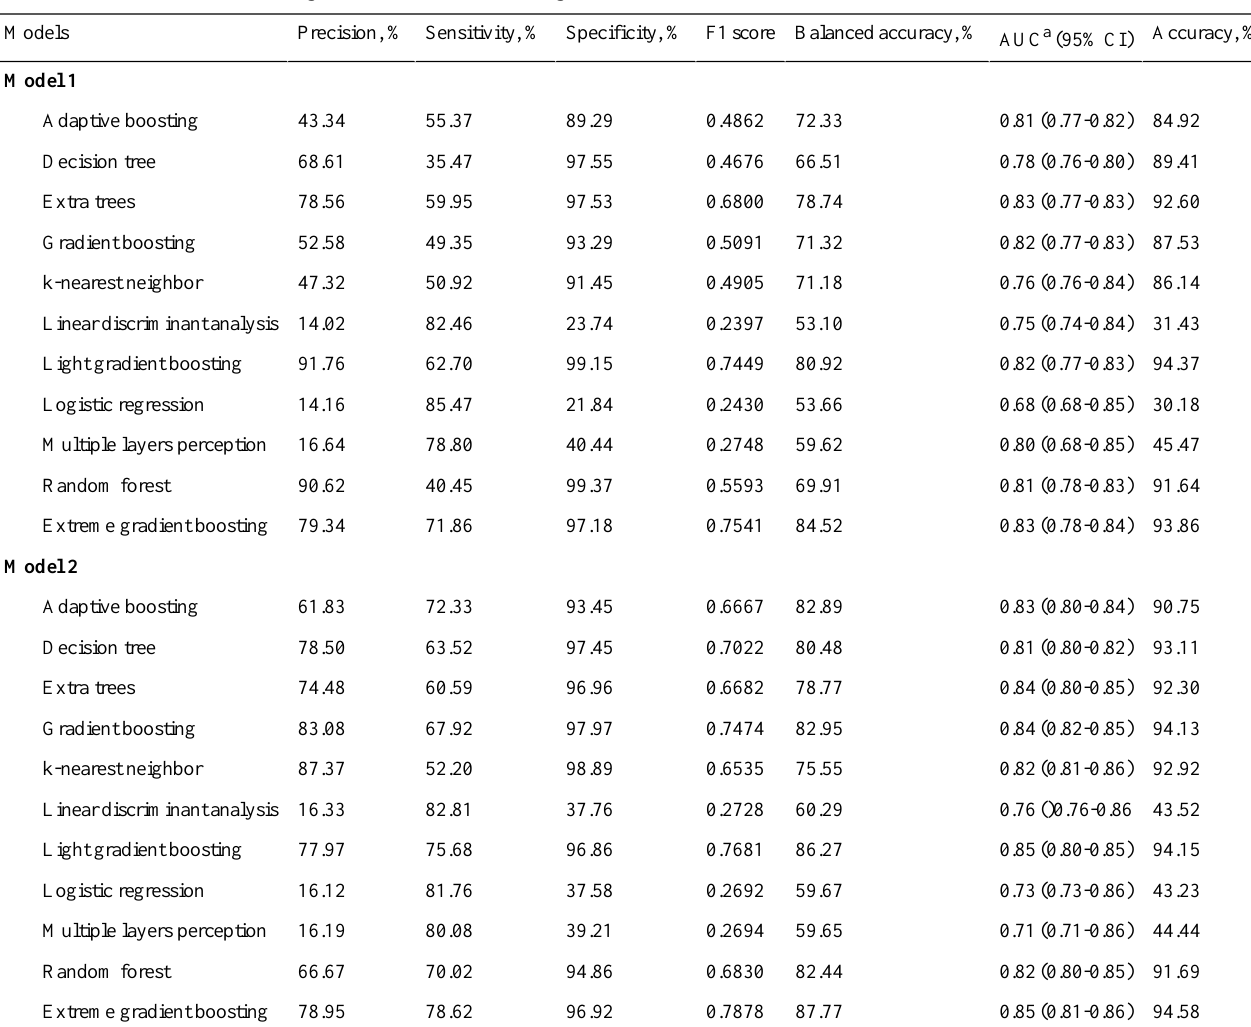
Table 2. Performance of different algorithms trained on the testing data